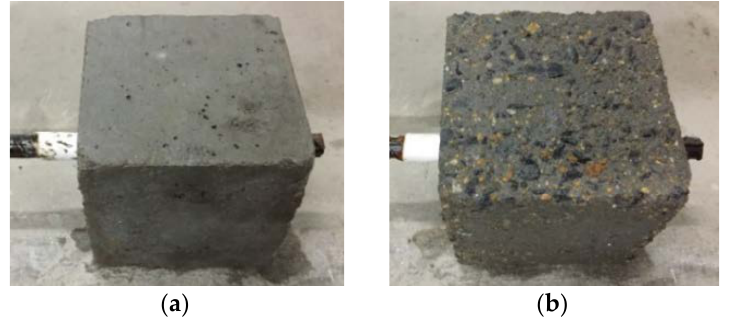
Figure 4. Appearances of concrete before and after freeze–thaw. ( a ) 0 cycleof salt frost; ( b ) 100 cycles of salt frost.